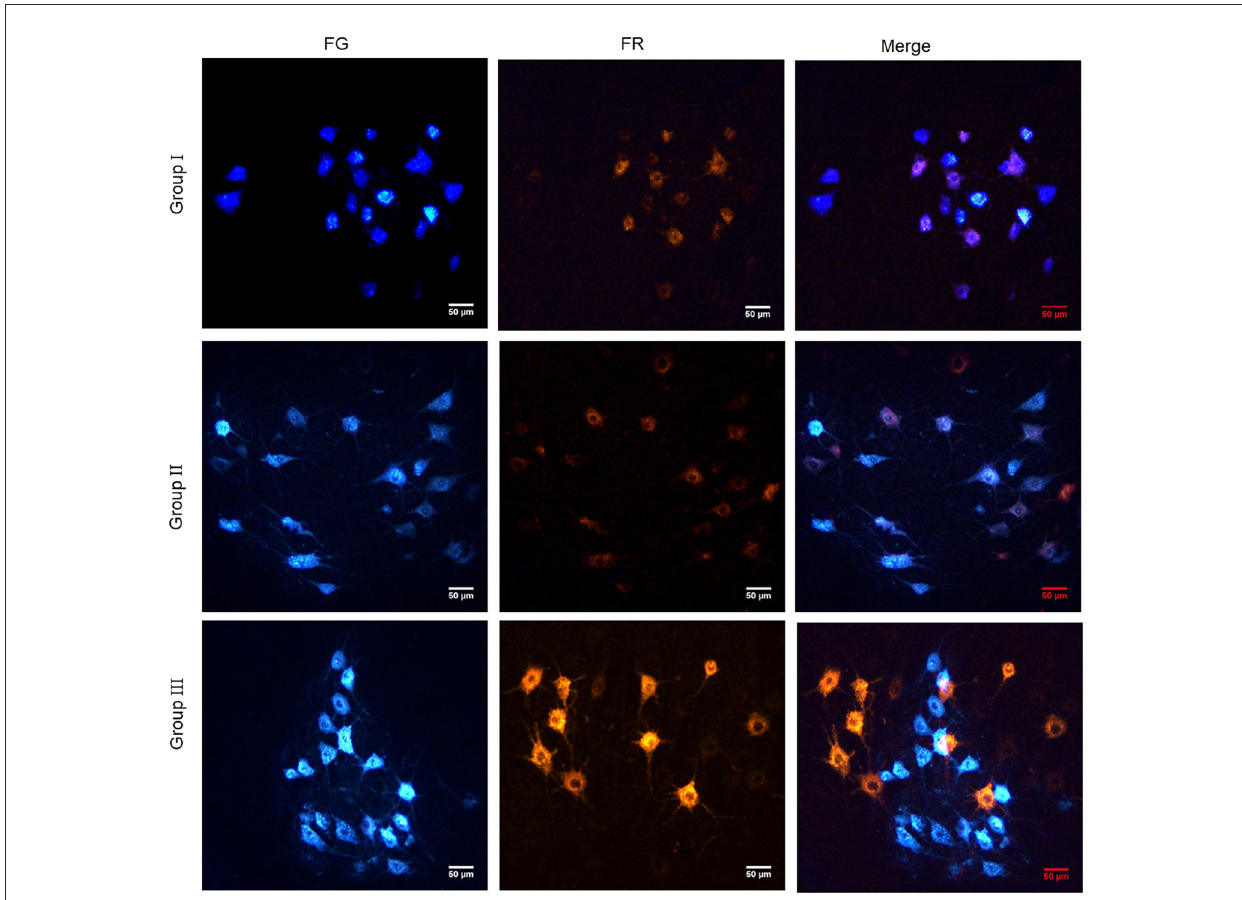
FIGURE8 Retrograde tracing of neurons showed the reinnervation connection between neurons and effectors. In Group I, only the distal end of the common peroneal nerve was fostered; in Group II, both proximal and distal ends of the common peroneal nerve were fostered; Group III was sham operated normal